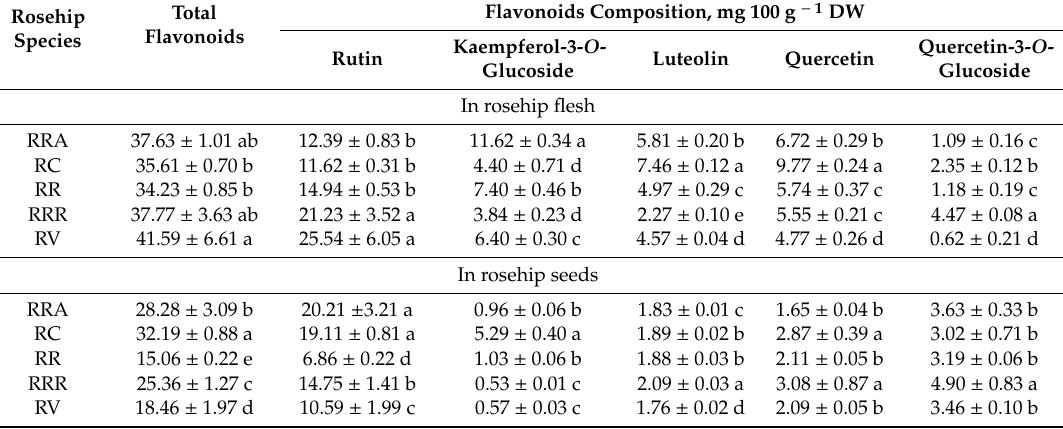
Table 3. Flavonoids composition and content (mg 100 g − 1 DW) of di ff erent organic rosehip flesh and seeds